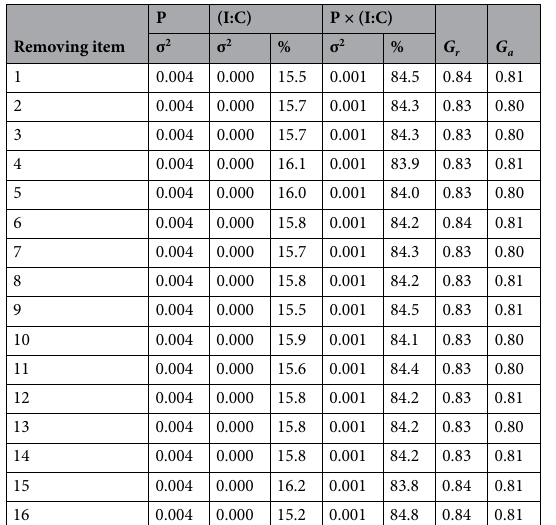
Table 2. D-study reliability estimates and variance components for the Person (P) × Item (I): Country (C) design including interactions for the Stroke Riskometer with removing one item at a time.